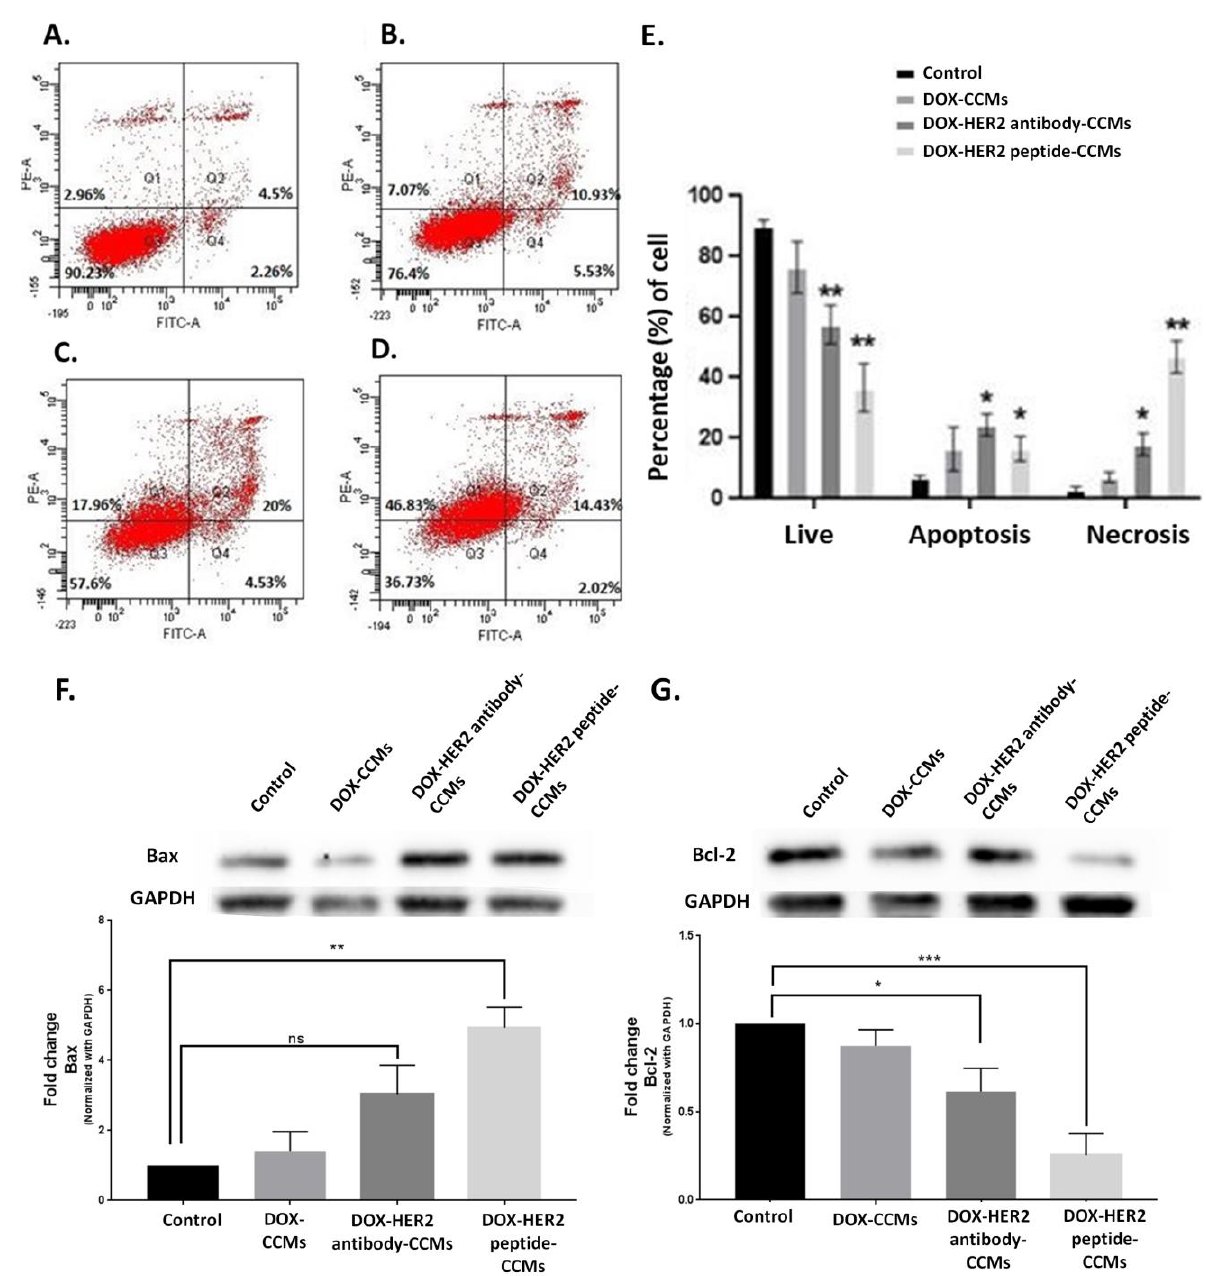
Figure 8. The apoptotic effects of the control ( A ), IC50-loaded DOX molecule-loaded ( B ), DOX-loaded HER2-peptide CCMs ( C ), HER2-antibody CCMs ( D ) with Annexin V/PI double staining and protein expression level of Bax ( F ) and Bcl-2 ( G ) with Western blotting on the SKBR-3 breast cancer cells after 48 h of incubation. ( E ) Percentage (%) of live, apoptotic, and necrotic cells after treatment with DOX-CCMs, DOX-HER2 antibody CCMs, and DOX-HER2 peptide CCMs. Note that, these experiments were performed in triplicate and repeated three times under similar conditions, and paired t -test was performed for statistical analysis, and p < 0.05:*, p < 0.01:**, and p < 0.001:*** were considered significant. Non-significant was shown as ns.